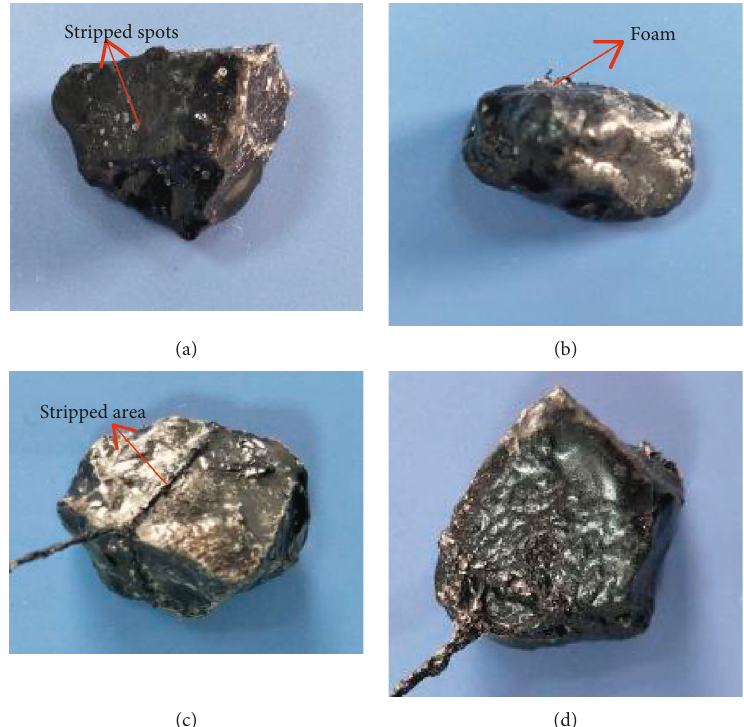
Figure 14: The adhesion test results of the PU binder: (a) limestone+PU (water immersion); (b) basalt+PU (water immersion); (c) limestone+PU (water boiling); (d) basalt +PU (water boiling).